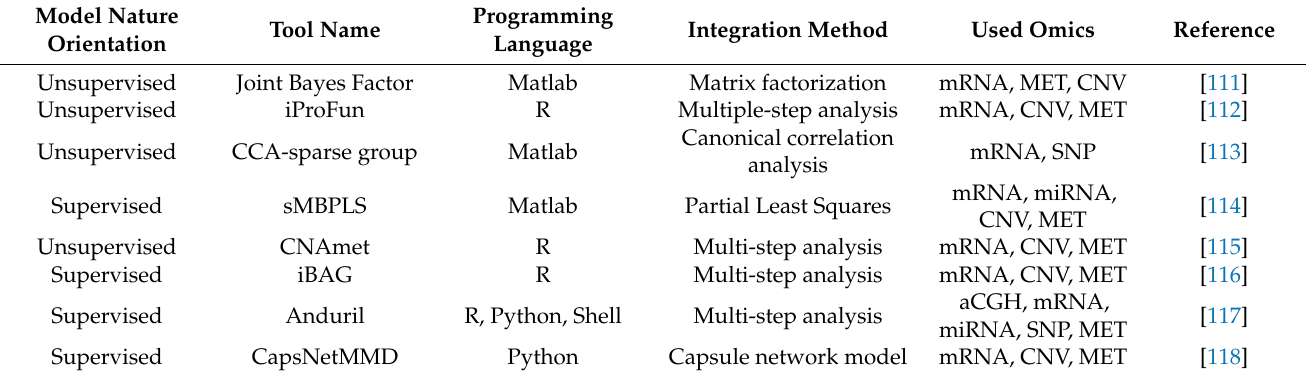
Table 3. Summary of computational tools for biomarker discovery in the field of multi-omics data integration. Model